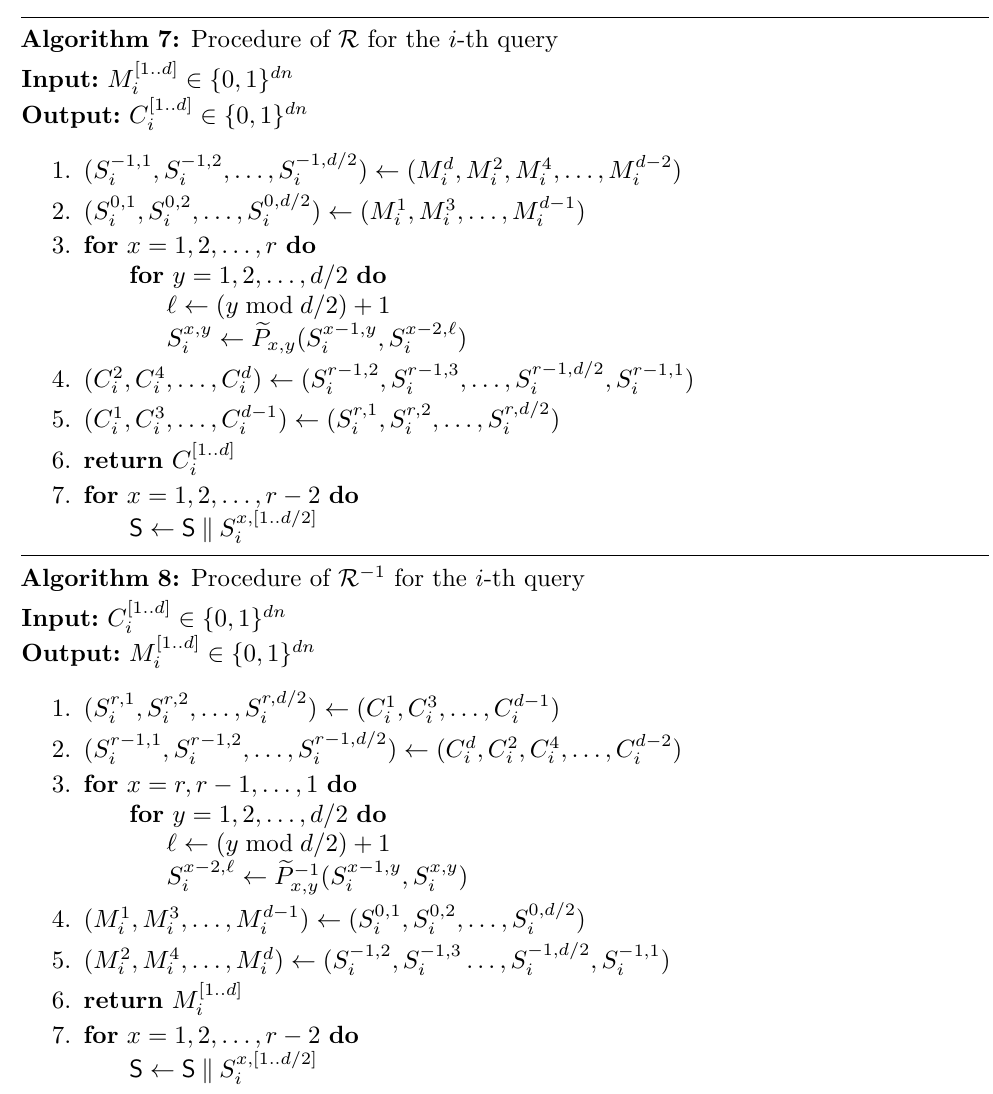
Figure 11: Definition of R and R − 1 for the SPRP proof of E 2 ,d,r . Initially, S is empty, and it is given to A after it makes all the q